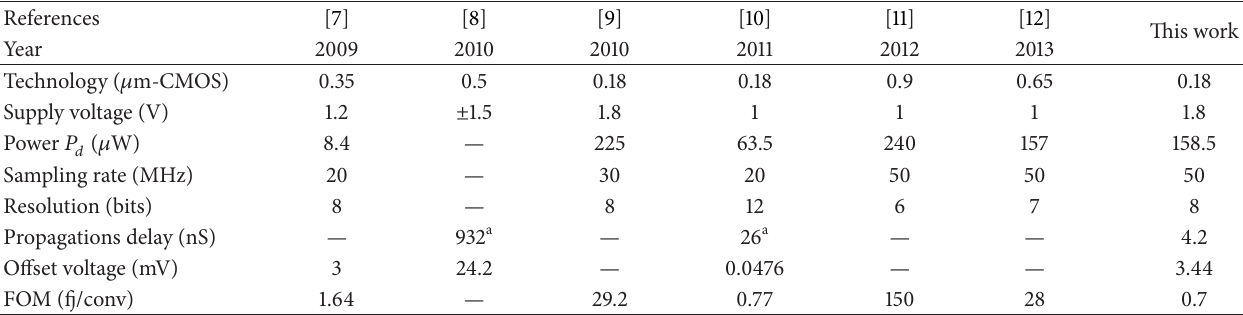
Table 2: Comparison study of the proposed latch comparator